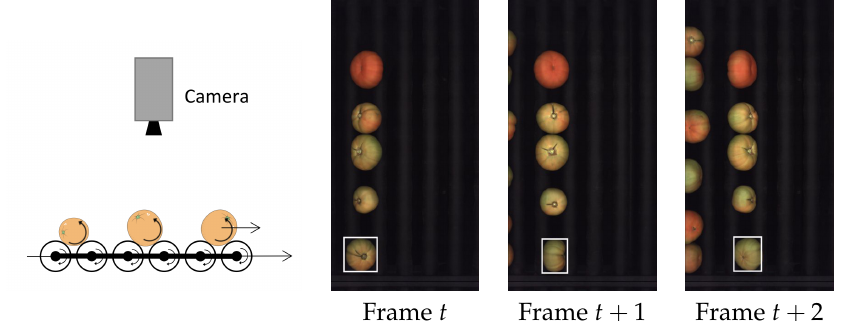
Figure 1. Roller conveyor unit used to obtain the different views of the rotating fruit and three consecutive camera frames. The fruit rotate while traveling to the